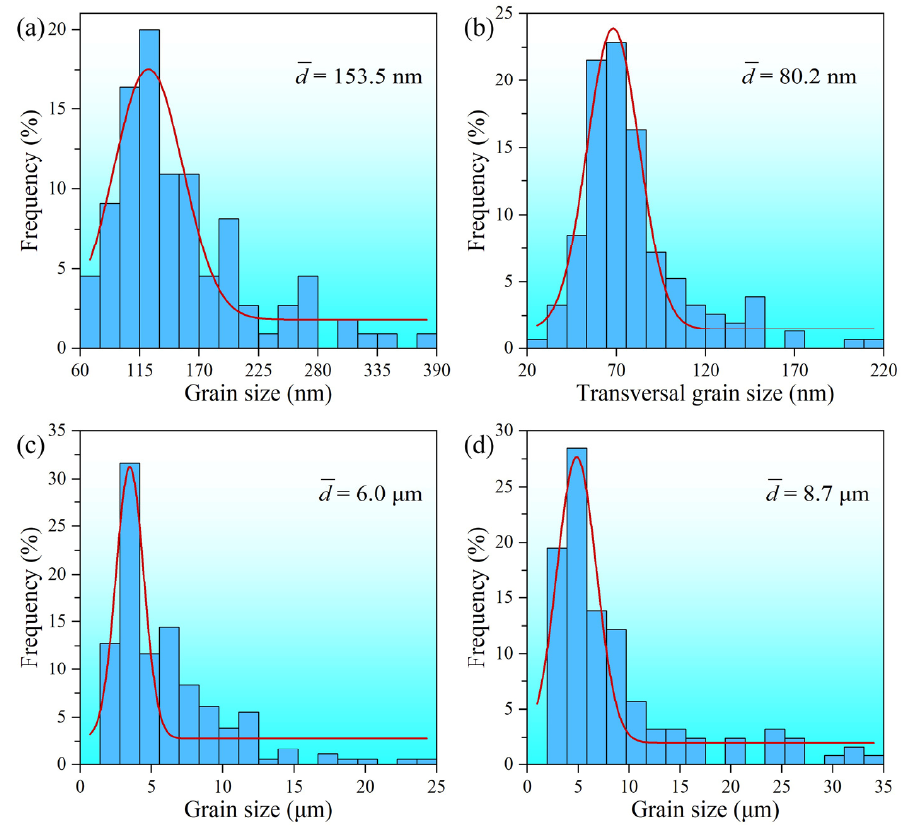
Figure 3. Distribution of structure size at the depth of ( a ) 0 µ m; ( b ) 50 µ m; ( c ) 300 µ m; and ( d ) 700 µ